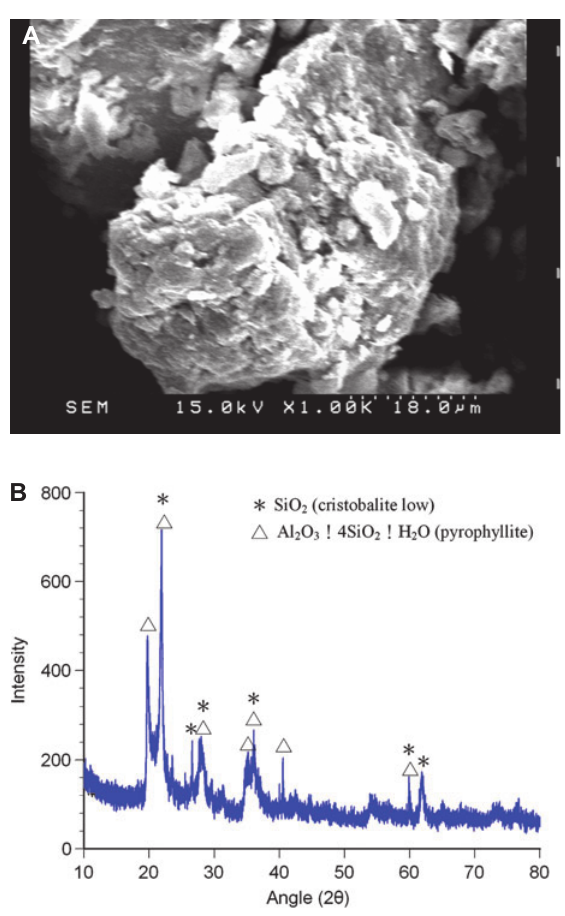
Figure 1 (A) SEM micrograph for the montmorillonite powder; (B) XRD pattern for the montmorillonite powder.